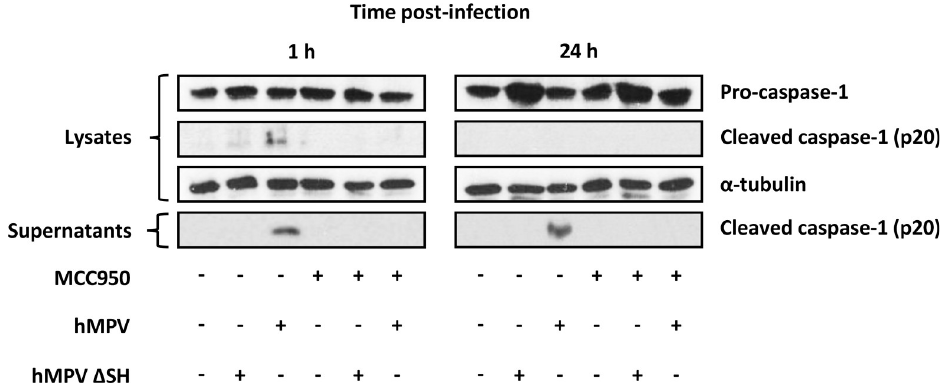
Fig 6. Cleavage of pro-caspase-1 into caspase-1 by HMPV. THP-1 cells were differenciated into macrophages using PMA (100 ng/ml) before treatment with 10 μ M of MCC950 or DMSO (control) and then infected or not with HMPV or HMPV Δ SH at a MOI of 0.001. At 1 or 24 h post-infection, cell lysates and supernatants were harvested for Western Blot analysis of caspase-1 activation. The results were representative of three independent experiments.